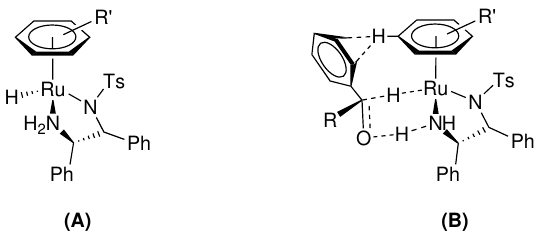
Figure 1. ( A ) Structure of Noyori’s ruthenium arene TsDPEN active catalyst for ATH of ketones. ( B ) Noyori’s catalyst operates through a concerted outer-sphere mechanism where the substrate does not directly bind to the metal center. For aryl ketone substrates, the transition state is stabilized by CH/ π interactions between the catalyst and ketone.